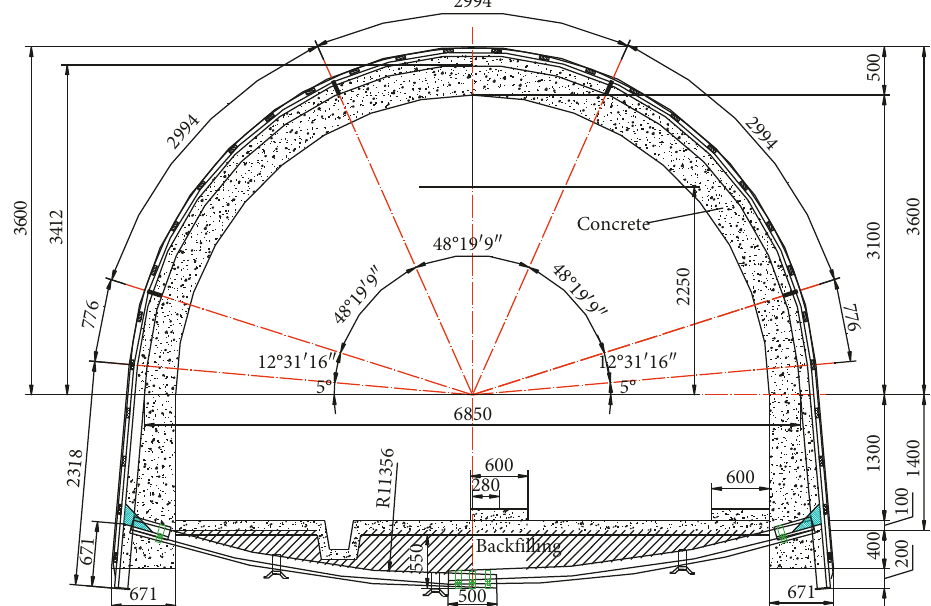
Figure 8: Supporting diagram of the inclined shaft in the gob, reproduced from Peng et al. [13] (under the Creative Commons Attribution License/public domain).